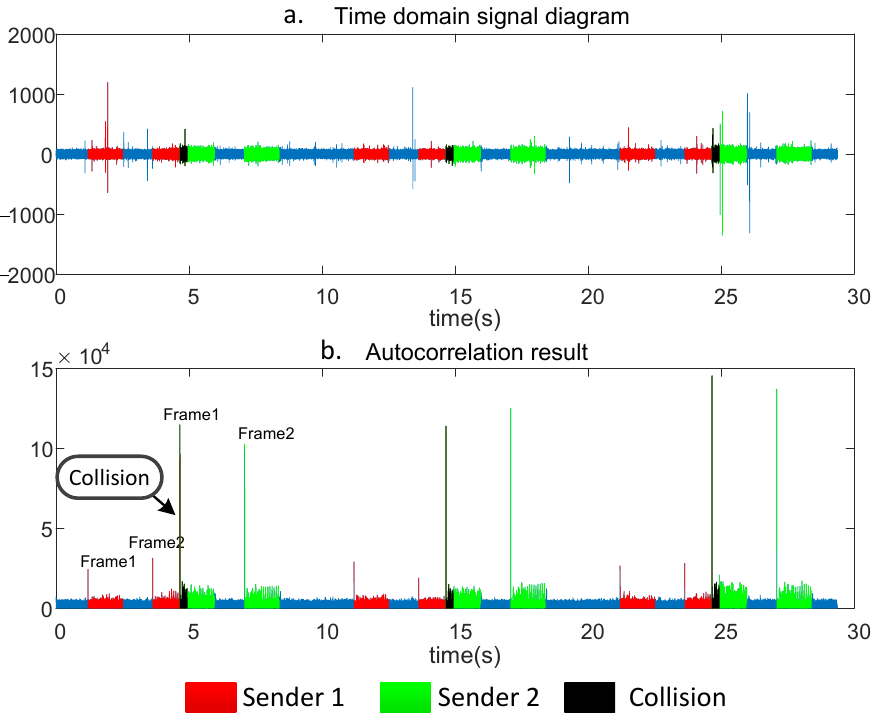
Figure 10. The signal received by the